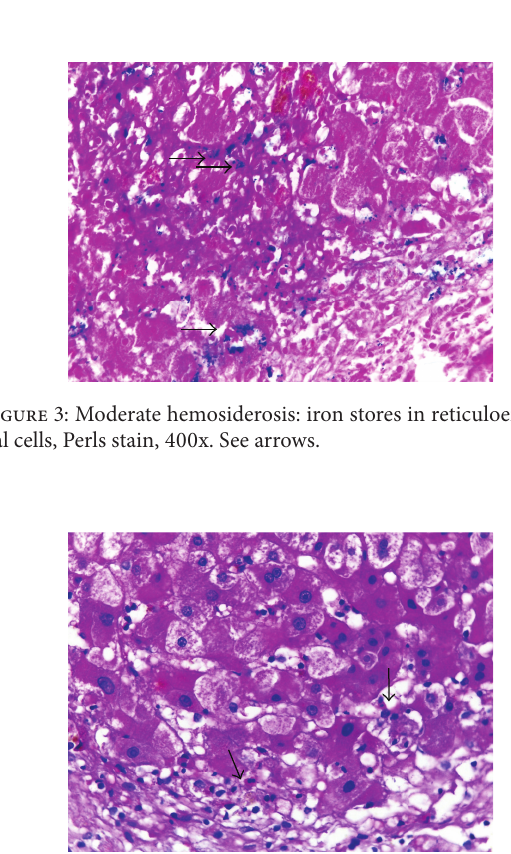
Figure 2: (a and b) Bridging periportal collapse with a mild number of inflammatory cells, HE, and Masson’s trichrome, 100x, respectively. See arrows.